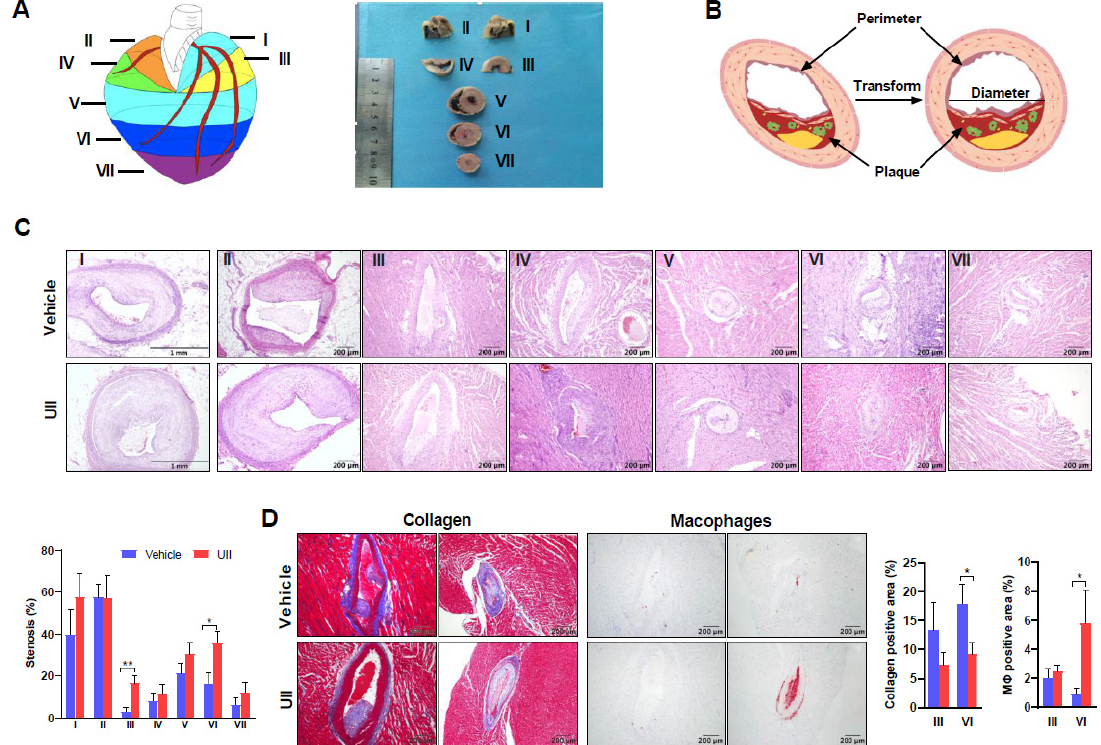
Figure 3. Analysis of coronary atherosclerosis. ( A ) Schematic illustration of heart sectioning pro- cedure. ( B ) Calculation method of coronary atherosclerotic lesions. ( C ) Representative figures of coronary atherosclerosis of seven blocks. The sections were stained with H&E stain of each group. Quantification of coronary arterial stenosis rate (%) (left panel). * p < 0.05, ** p < 0.01 vs. vehicle group. ( D ) The lesions (blocks III and VI) were either stained with Masson trichrome for collagen or immunohistochemically stained with anti-M ϕ Ab (left panels). Positively stained areas were quantified (right panel). n = 3–10/group, all data are presented as mean ±